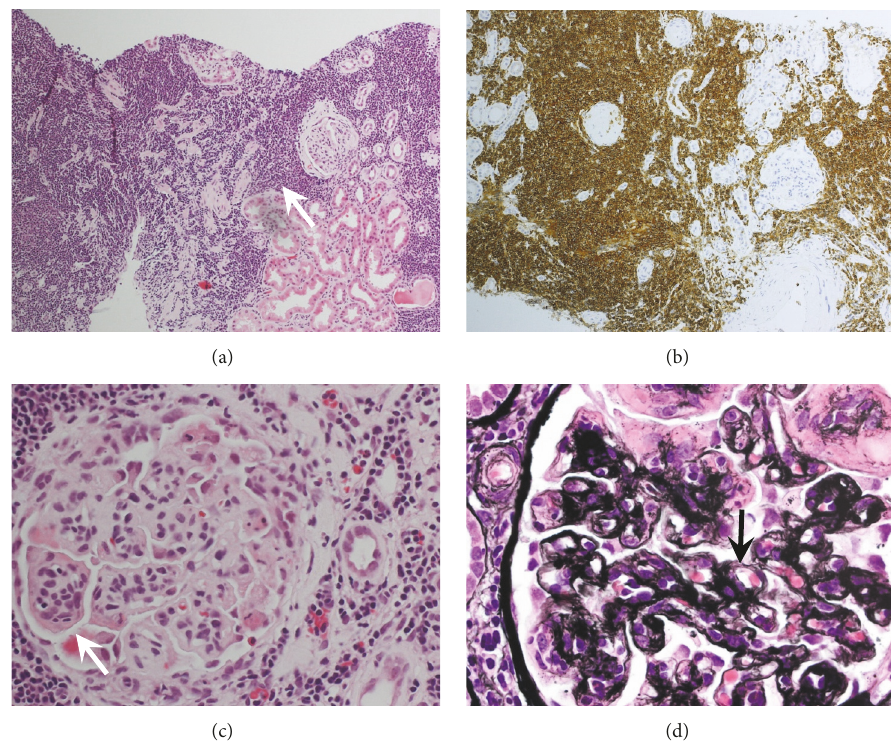
Figure 5: Percutaneous renal biopsy: (a) Haematoxylin and eosin stain showing dense lymphoid infiltrate. (b) Immunoperoxidase stain showing positive staining of lymphocytes for CD5. (c) Haematoxylinand eosin stain showing lobulation of glomeruliin keeping with MPGN. (d) Silver stain showing thickening and double contouring of basement membrane in keeping with